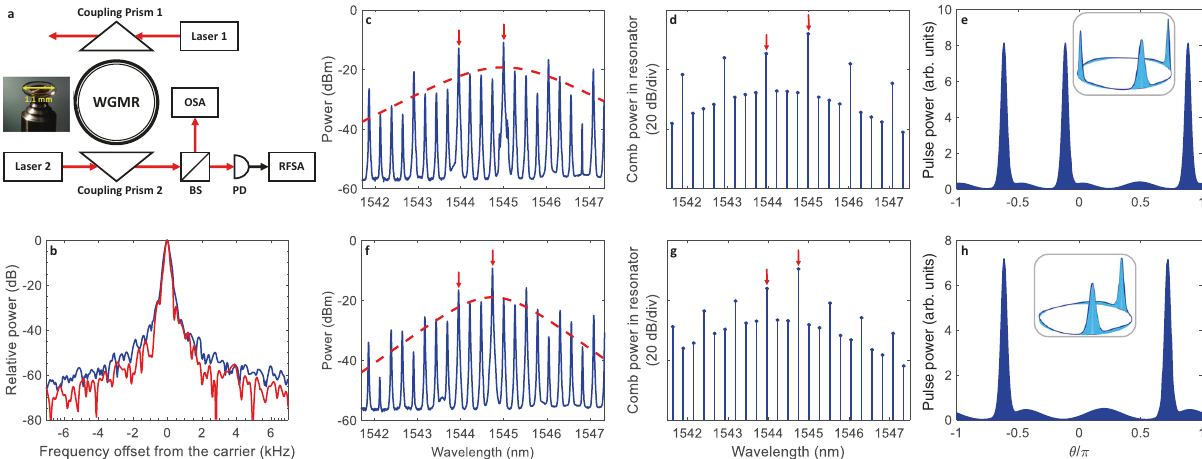
Fig. 4 Experimental observation of all-optical DTCs. a Experimental setup; WGMR: whispering gallery mode resonator, OSA: optical spectrum analyser, RFSA: radio frequency spectrum analyser, BS: beam splitter, PD: photodetector. b RF signal ensuring stable pulse train generation. For the two pumps locked to two adjacent cavity modes, a narrow RF signal is generated (blue, 32.8 GHz carrier frequency). When locking to non-adjacent modes, the generation of frequency harmonics between the pumps (subharmonics) and hence solitons trapped in the background lattice further narrows the RF signal peak. An example is the red curve (32.8 GHz carrier frequency), corresponding to the experimental spectrum plotted in f in which M = 3. c , f Spectra corresponding, respectively, to period-quadrupling ( M = 4) and period-tripling ( M = 3) DTCs. Pumps are marked by red arrows, and red dashed curves show soliton envelopes. The stronger pump was at 1545 nm in c and 1544.8 nm in f . d , g Numerical modeling spectra matching c and f . e , h Time-domain pulse trains per round-trip time (numerical), with snapshots of pulses revolving around the resonator circumference as